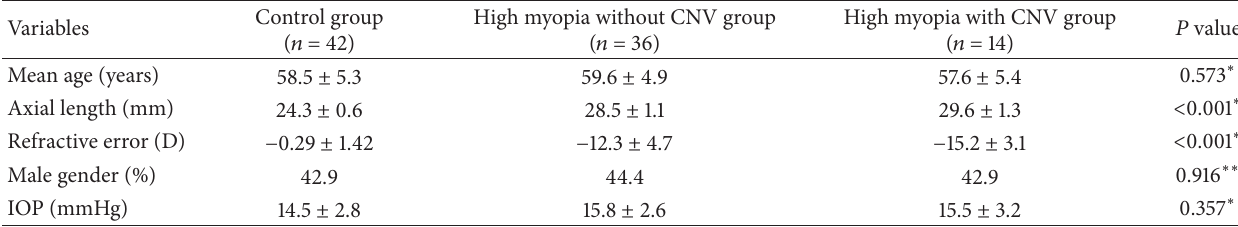
Table 1: Demographic and clinical characteristics.